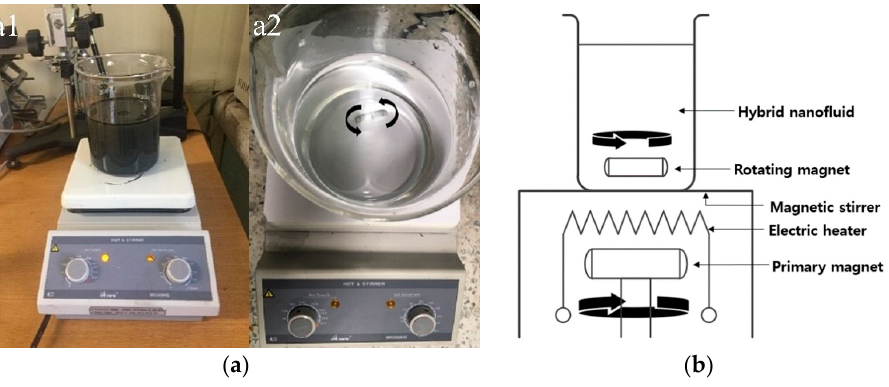
Figure 2. ( a ) Photo of the magnetic stirrer ( a1 ) and the rotating magnet ( a2 ); ( b ) schematic diagram.